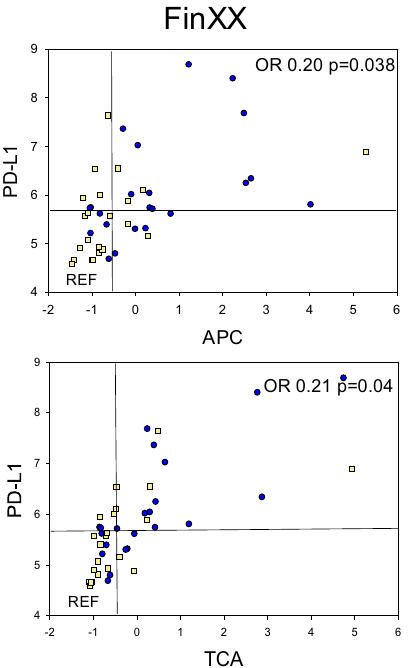
<median for both features (e.g., APClow/TCAlow). Signi fi cance was de fi ned as p <0.05, and “ quadrants ” with p >0.05 for ORs are designated as “ ORns ” . ORs for FinXX APClow/TCAhigh and APChigh/TCAlow are not given in Fig. 3, considering the low number of samples in these quadrants. However, ORs for all quadrants are given in Supplementary Table 3. Source data are given in Supplementary Data 2 (FinXX tumor-average abundance), Supplementary Data 7 (TNBC_TMA), and